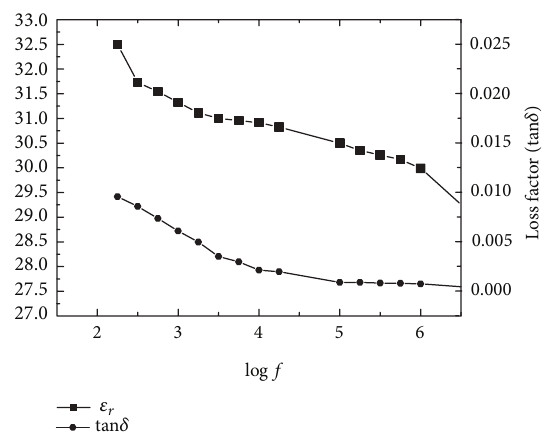
Figure 10: Variation of 𝜀 𝑟 and tan 𝛿 with the frequency.